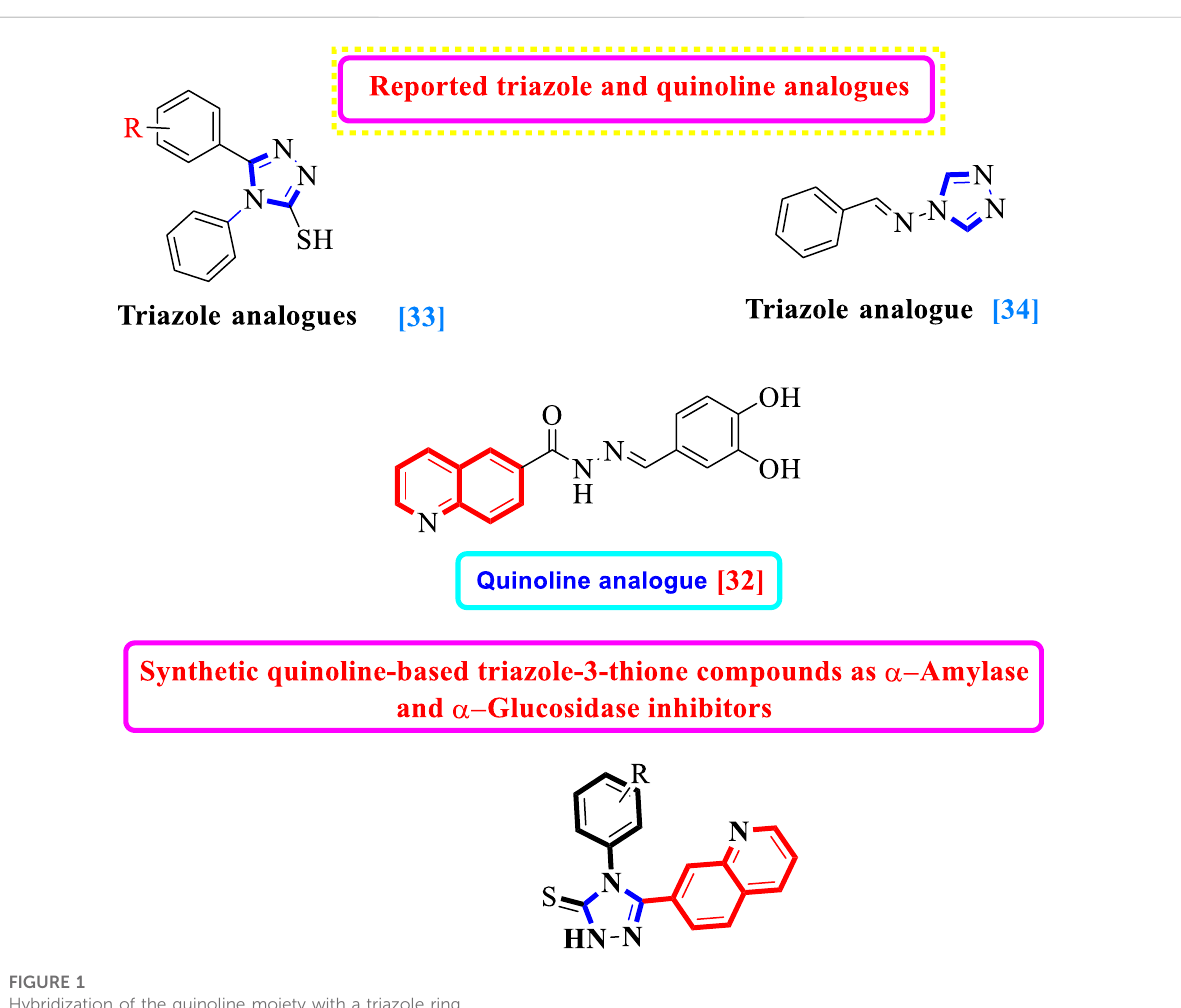
FIGURE 1 Hybridization of the quinoline moiety with a triazole